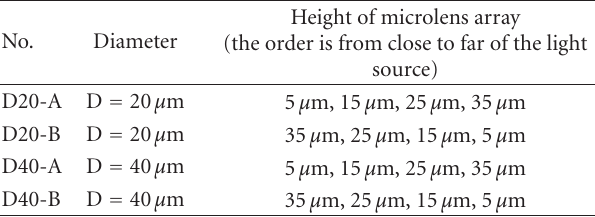
Table 1: Parameters of gray scale microlens